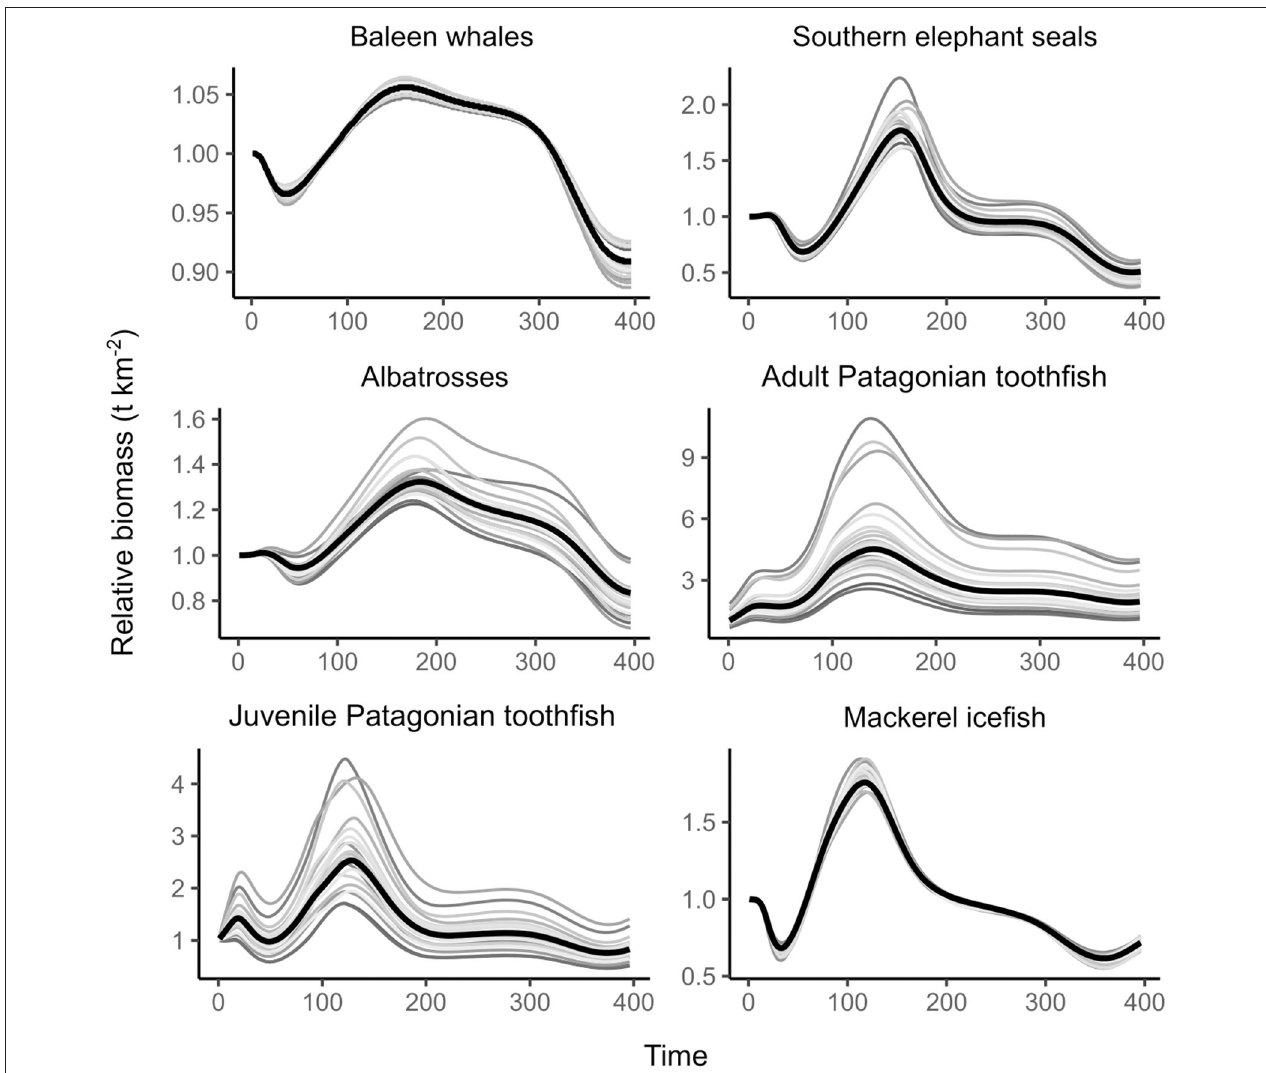
FIGURE 5 | Results from the Monte Carlo simulations for the best-fitting model. Gray lines represent the biomass trend for each of the 20 simulations and the black lines overlay the biomass trend from the best-fitting model. Time is provided in months where January 1986 = 1.